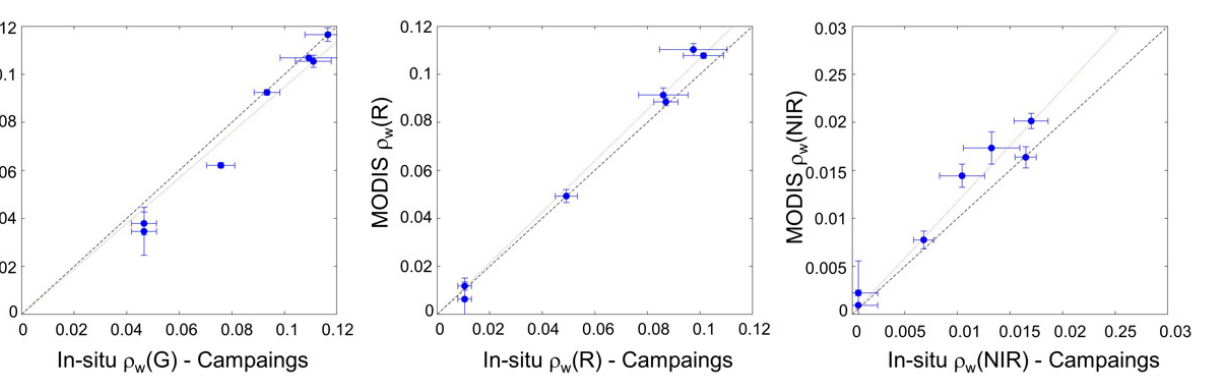
Figure A7. ρ w vs. SPM relationships obtained for the green ( A ), red ( B ) and NIR ( C ) bands of the OLI sensor with in situ data acquired in the Rhône River plume during sea campaigns (blue points and blue dashed lines); OLI- and MSI-derived ρ w values extracted from the SORA pixel with (red triangles and red dashed line) and without (pink triangles and pink dashed line) glint correction and in situ SPM concentration measured at the SORA station. The relationships selected in this study correspond to the blue dashed line for the green and red relationships and to the dark line for the NIR one. The C ρ coefficients are fixed to the [38] values for the river plume relationships but are fitted to the data for the satellite-derived relationship from the SORA station.